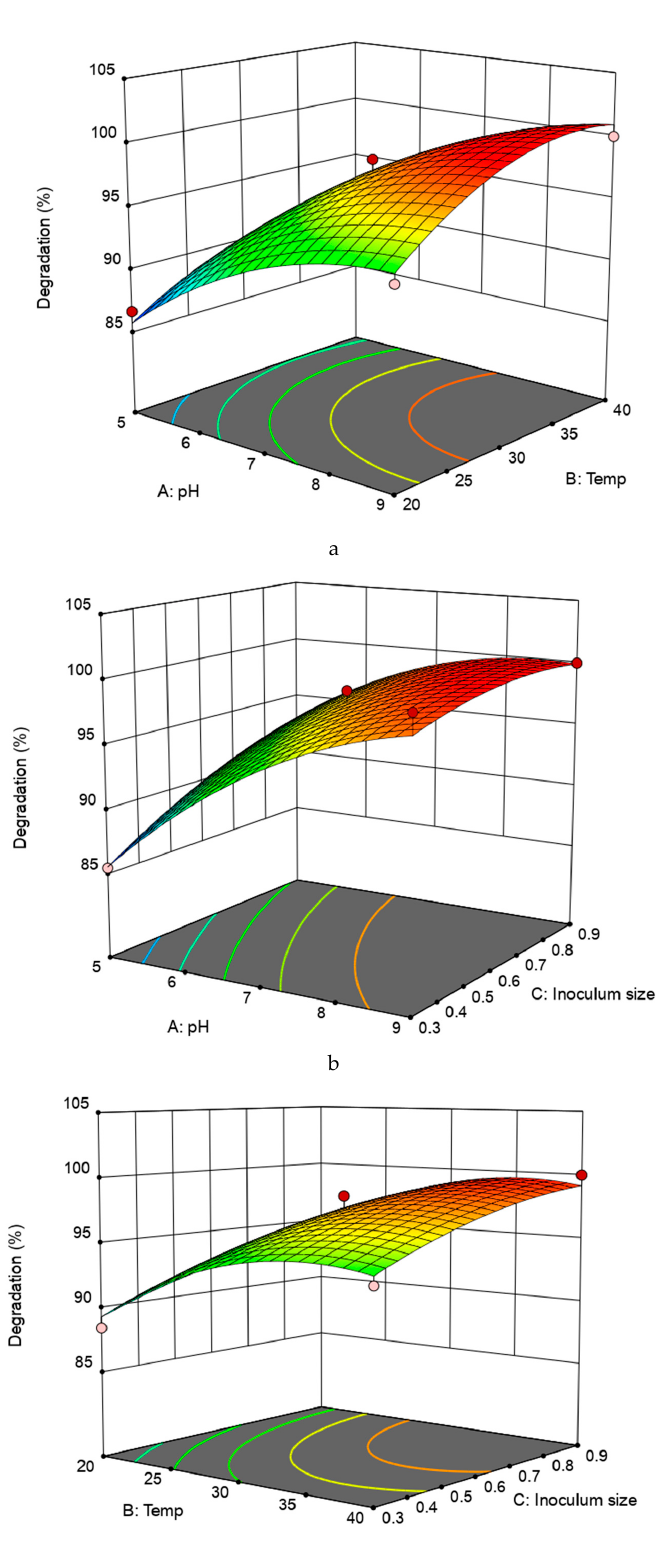
Figure 5. Response surface showing the interactive effects of pH (A), temperature (B), and inoculum size (C) on tetramethrin degradation by strain A16. ( a ) 3D plot illustrating the interactive effect of pH (A), temperature (B) on tetramethrin degradation; ( b ) 3D plot illustrating the interactive effect of pH (A) and inoculum size (C) on tetramethrin degradation; ( c ) 3D plot illustrating the interactive effect of temperature (B) and inoculum size (C) on tetramethrin degradation.